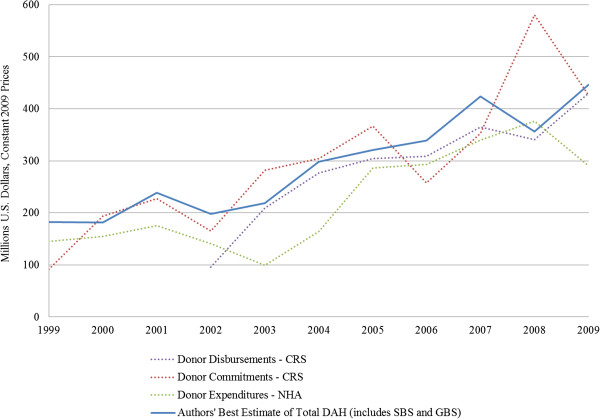
Trends in total DAH 1999–2009. Sources: WHO [29]; OECD/DAC [27].